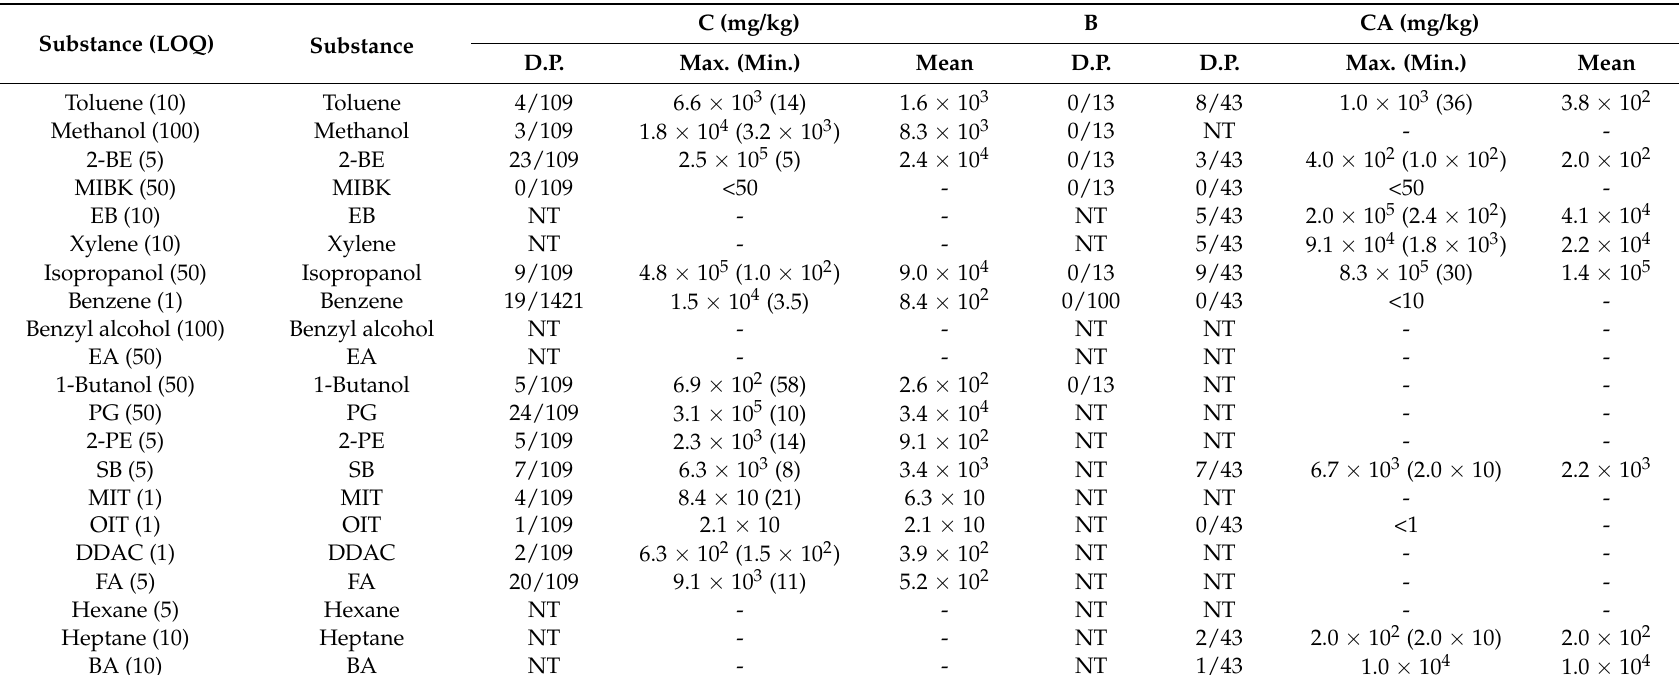
Table 4. Analyzed concentrations of studied substances in products C, B and